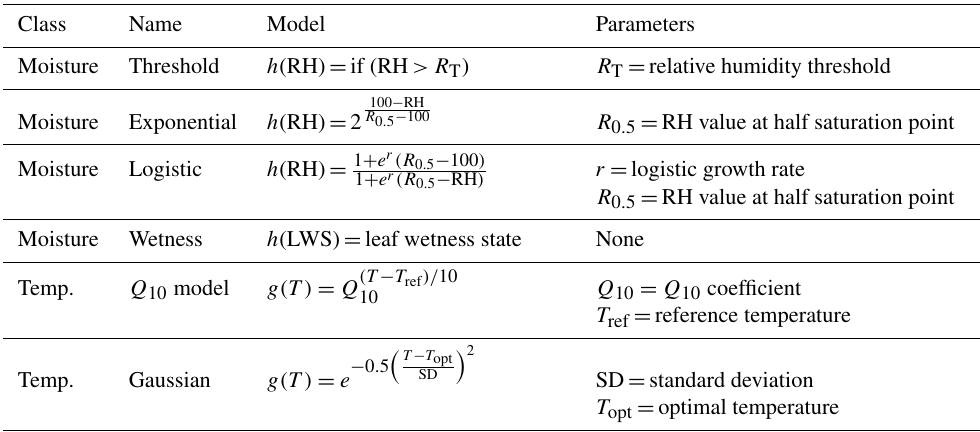
Figure 1. Temperature and NRM sensitivity functions included in the models. Each curve shows one parameter combination chosen by random sampling using a normal distribution around a specified set of priors as identified in Table 2 ( n = 895230 total combinations). The wetness moisture function has no parameter and is simply the proportion of time during each hour that the leaf wetness sensor detected the presence of moisture. Table 1. Moisture and temperature sensitivity functions. The first three moisture functions are based on relative humidity and the fourth is based on leaf wetness state. Moisture functions are normalized to 1 at 100% relative humidity and temperature sensitivity functions are normalized to 1 at T ref and T opt . “RH” is relative